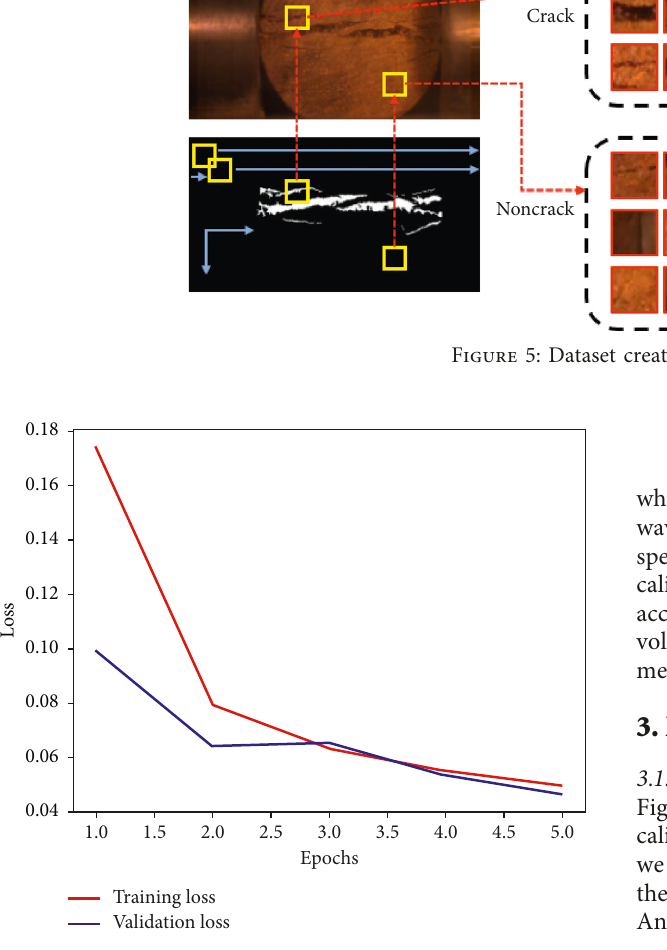
Figure 6: Loss curve in training process for CrackSHPB